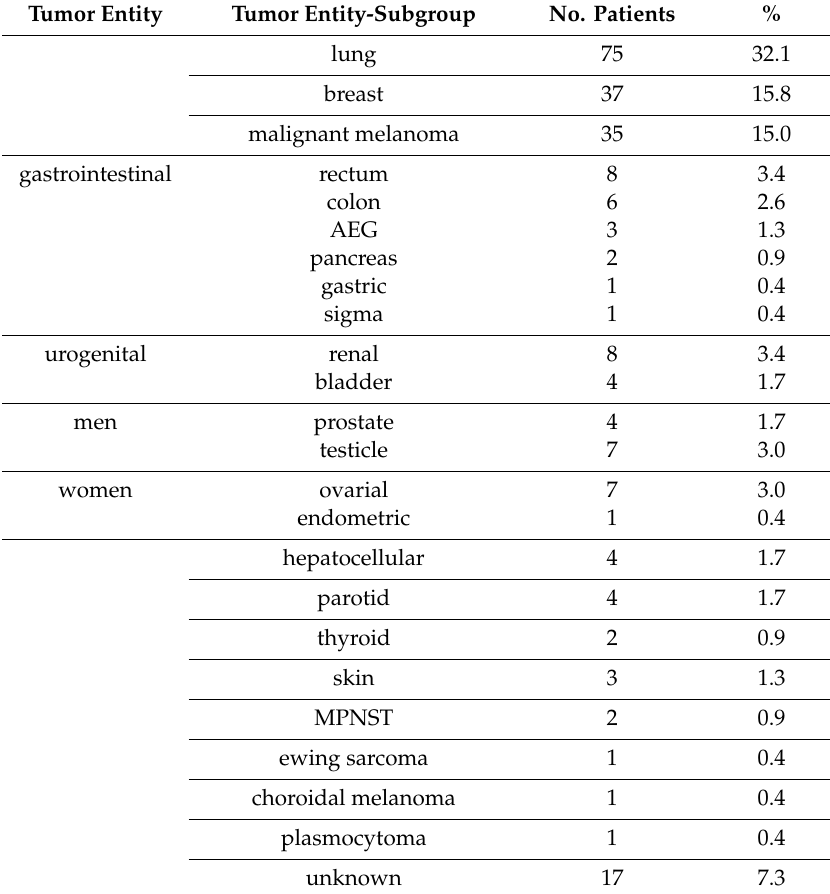
Table 2. Distribution of tumor